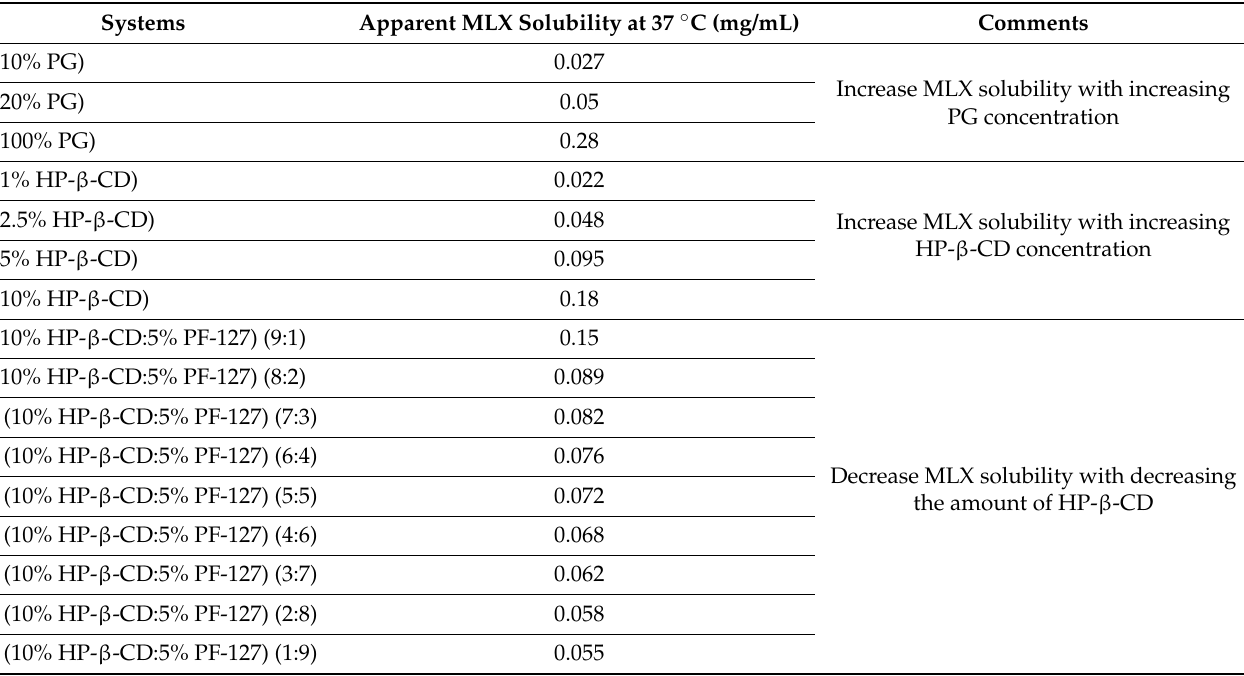
Table 5. Apparent solubility of MLX in different